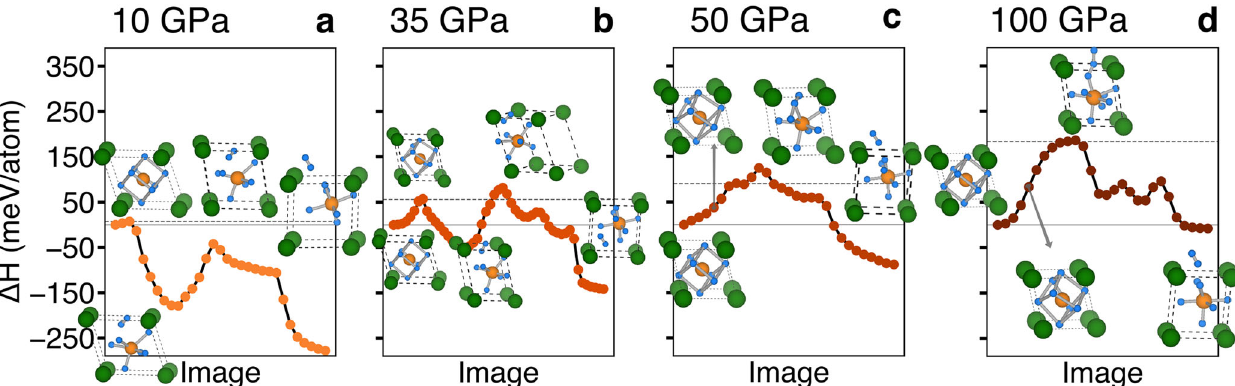
Fig. 6 VCNEB calculations for BaSiH 8 at different pressures. Minimum energy path (MEP) for BaSiH 8 at various pressures, calculated using the VCNEB method. Each point represents an individual crystal structure (image) along the path. Particularly relevant intermediate states are